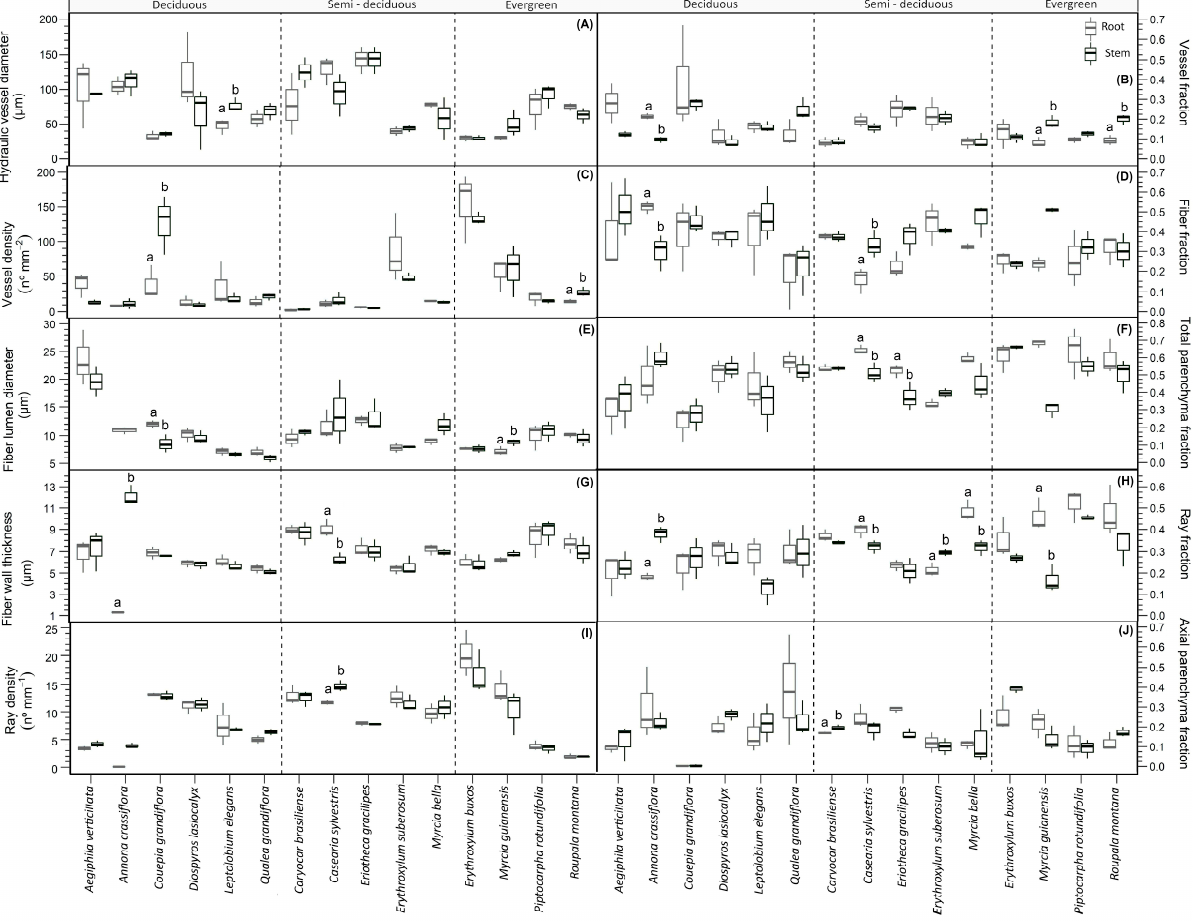
Figure 3. Anatomical xylem traits (i.e., hydraulic vessel diameter ( A ); vessel fraction ( B ); vessel density ( C ); fiber fraction ( D ); fiber lumen diameter ( E ); total parenchyma fraction ( F ); fiber wall thickness ( G ); ray fraction ( H ); ray density ( I ); axial parenchyma fraction ( J )) as function of species, organs, and leaf habits from Cerrado. Roots and stems are shown in gray and black, respectively. Boxplots show the median (horizontal line); the lower and upper boxplot represent the 25th and 75th percentiles, and whiskers represent 1.5 × the interquartile. Different letters indicate significant difference between organs for a given species ( p < 0.05).